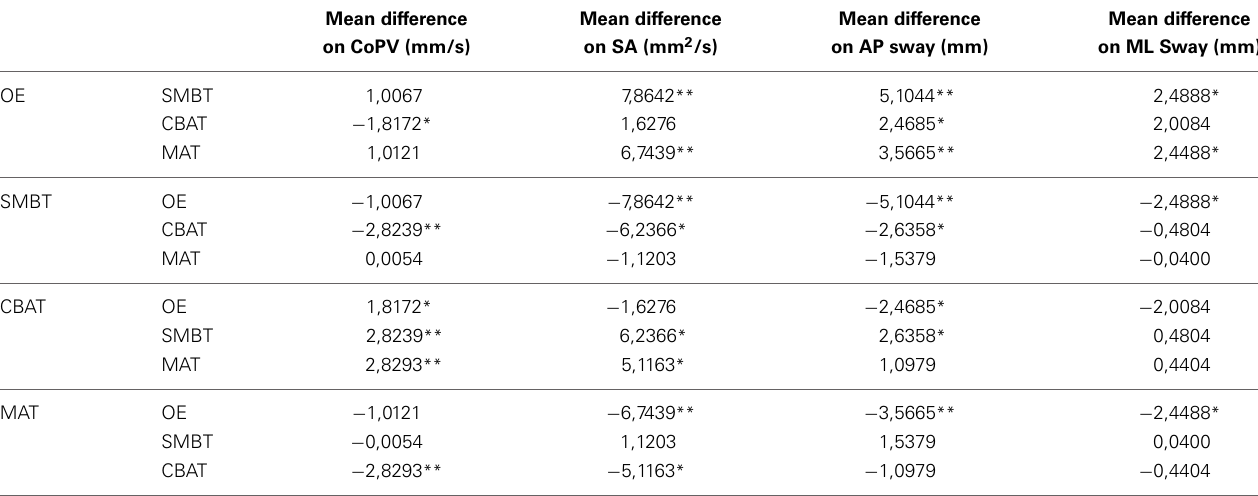
This table shows the post-hoc comparisons with the mean differences on CoPV, center of pressure velocity; SA, sway area; AP, antero-posterior; ML, medio-lateral, sways across the different secondary conditions: Romberg’s OE, open eyes standard position; SMBT, spatial-memory Brooks test; CBAT, counting backward aloud